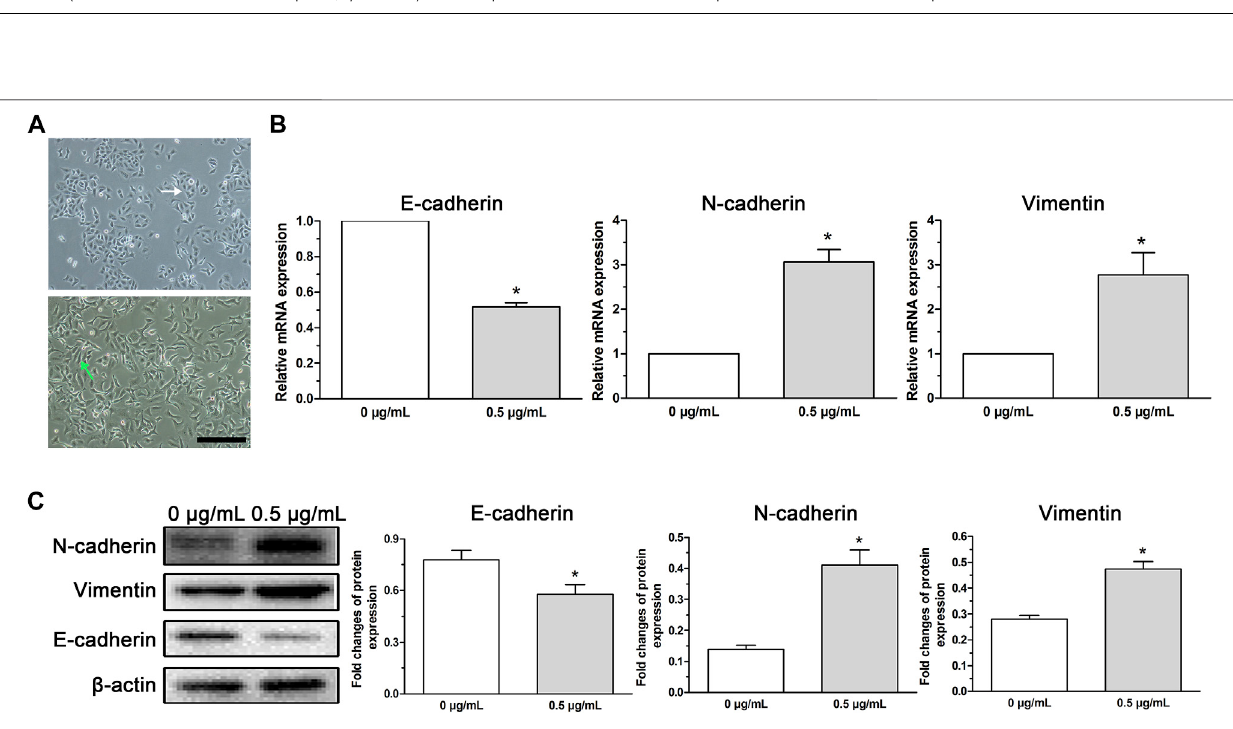
Frontiers in Genetics |